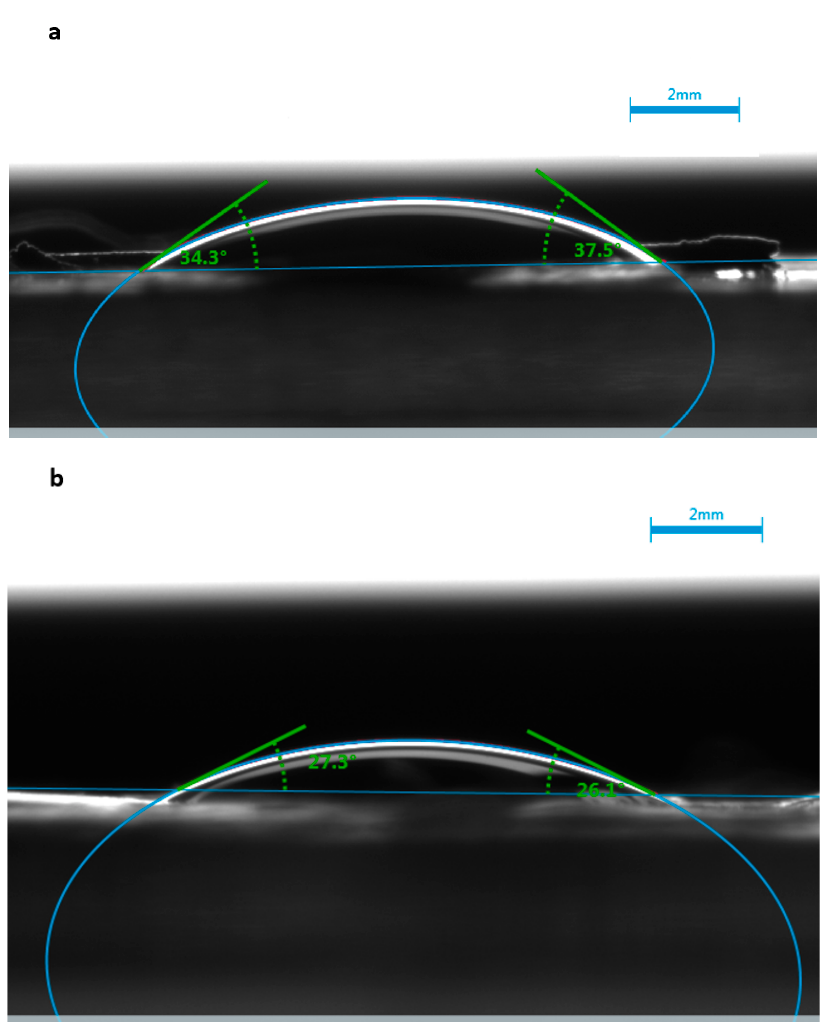
Figure 12. Contact angle analysis for samples ( a ) H1 and ( b ) H2 showing increase in hydrophilicity with N doping.